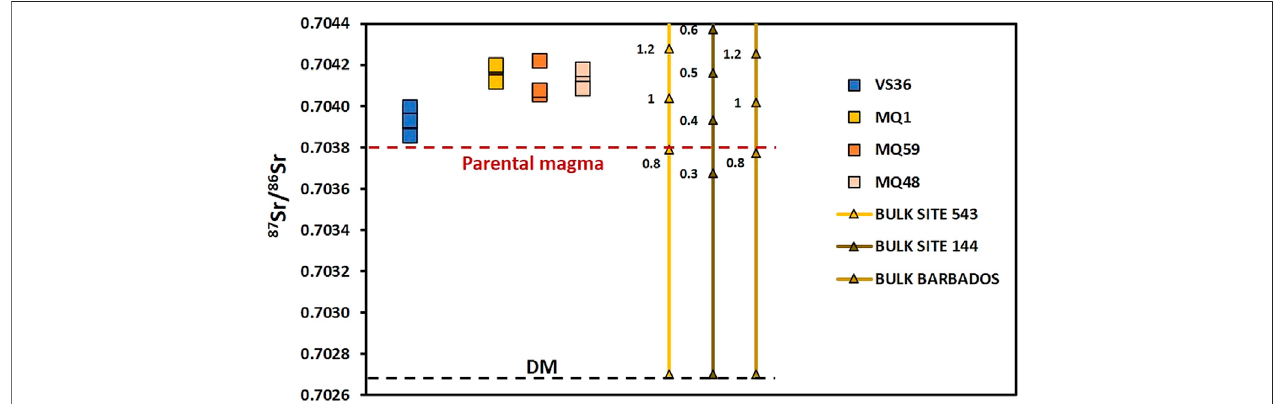
FIGURE 12 | 87 Sr/ 86 Sr of cumulate plagioclase compared with single component mixing lines between depleted mantle and potential subducted sediment end members. The subducted sediment end member from Table 3 corresponding to each mixing line is shown in the legend. Labeled tickmarks represent percentage sedimentadditiontomantlesource.Datasourcesasper Table3 .DashedlinelabeledDM (cid:1) depletedmantle[ 87 Sr/ 86 Sr (cid:1) 0.70270,fromSaltersandStracke(2004)].Red dashed line shows Martinique parental magma composition ( 87 Sr/ 86 Sr (cid:1) 0.70380). Where visible, black bars show uncertainty (2 SE), otherwise uncertainty is smaller than symbol